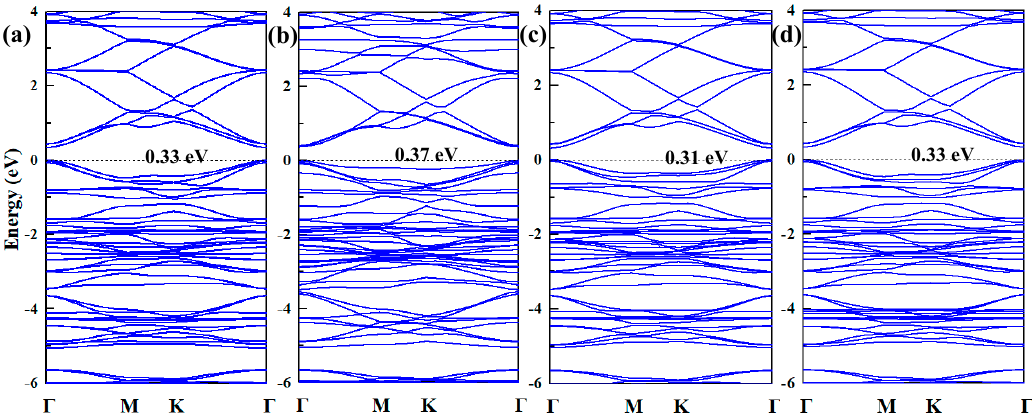
Figure 6. Band structure of ( a ) Pd-graphyne/H 2 ; ( b ) Pd-graphyne/CO; ( c ) Pd-graphyne/C 2 H 2 ; and ( d ) Pd-graphyne/CH 4 .